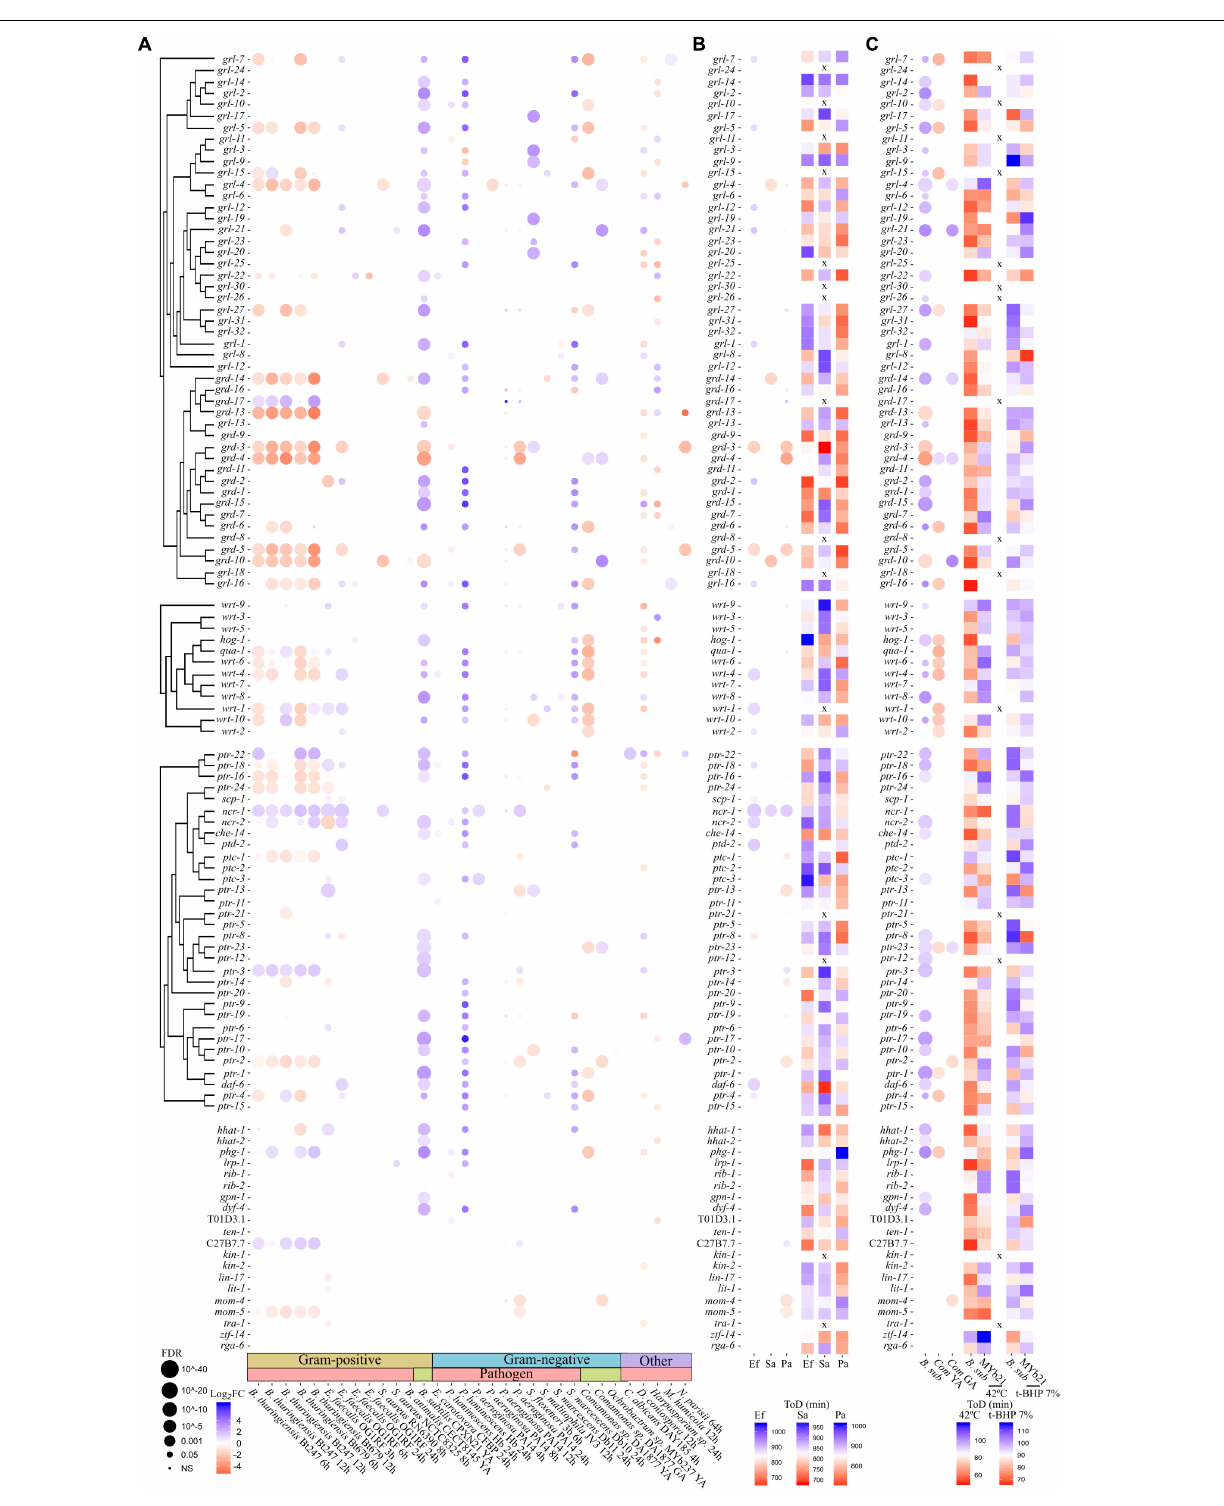
FIGURE 3 | In C. elegans Hedgehog-like (HHL) genes and genetic interactors play microbe-specific roles in the defense against infection and microbe-mediated protection from stress. (A) Bubble plots representing gene expression changes in Hedgehog-like (HHL), patched-related receptor (PTR) and hedgehog genetic interactors after exposure to different microbes. Bubble plots represent changes in gene expression as log2Fold Change (Log 2 FC) in a color heatmap and the adjusted p -value (FDR) as the diameter of the points. Published transcriptomic datasets were not re-analyzed from raw data, or re-scaled, therefore datasets